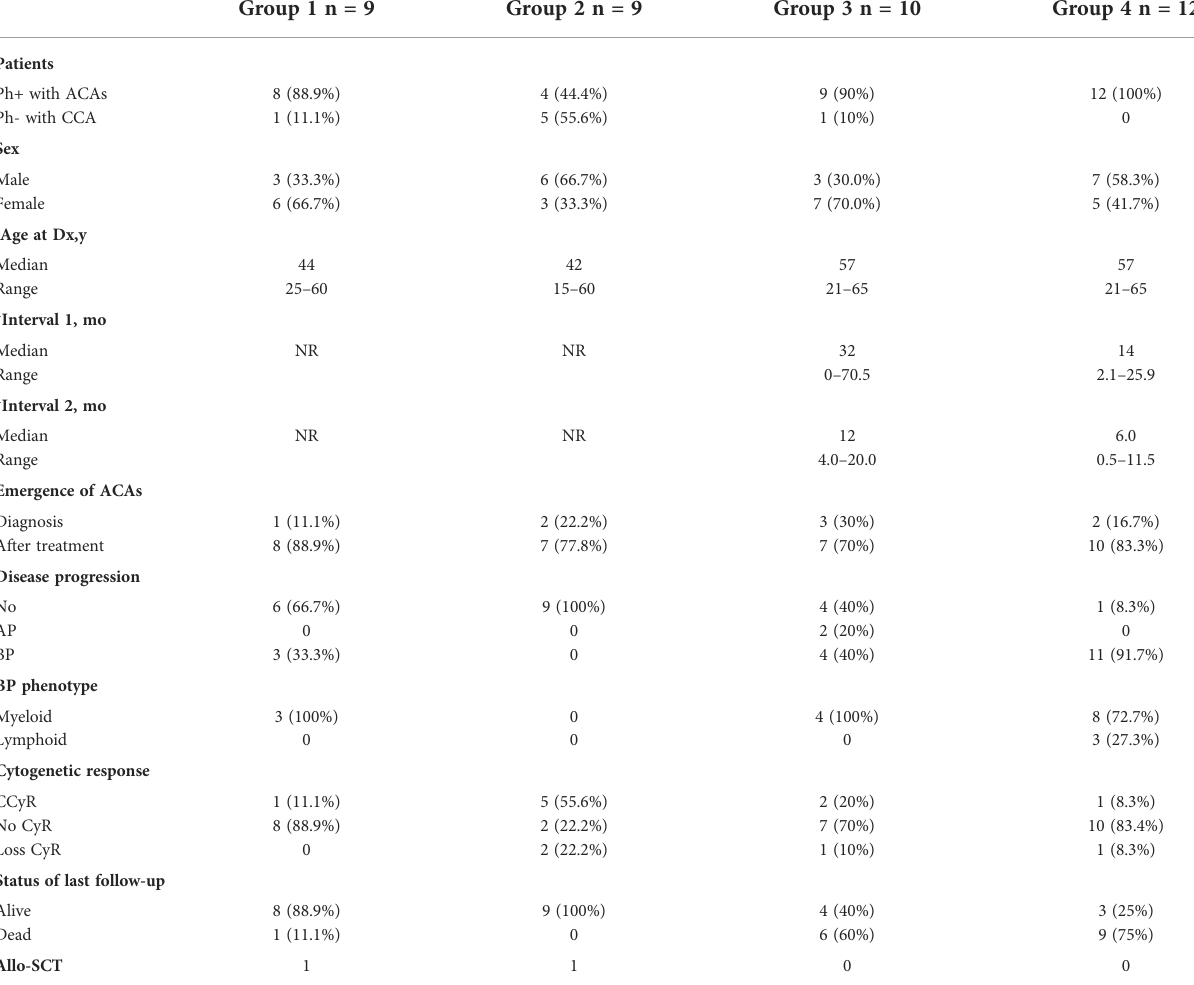
TABLE 2 Clinical characteristics, disease progression, and prognosis of four groups of CML patients with ACAs at diagnosis and during